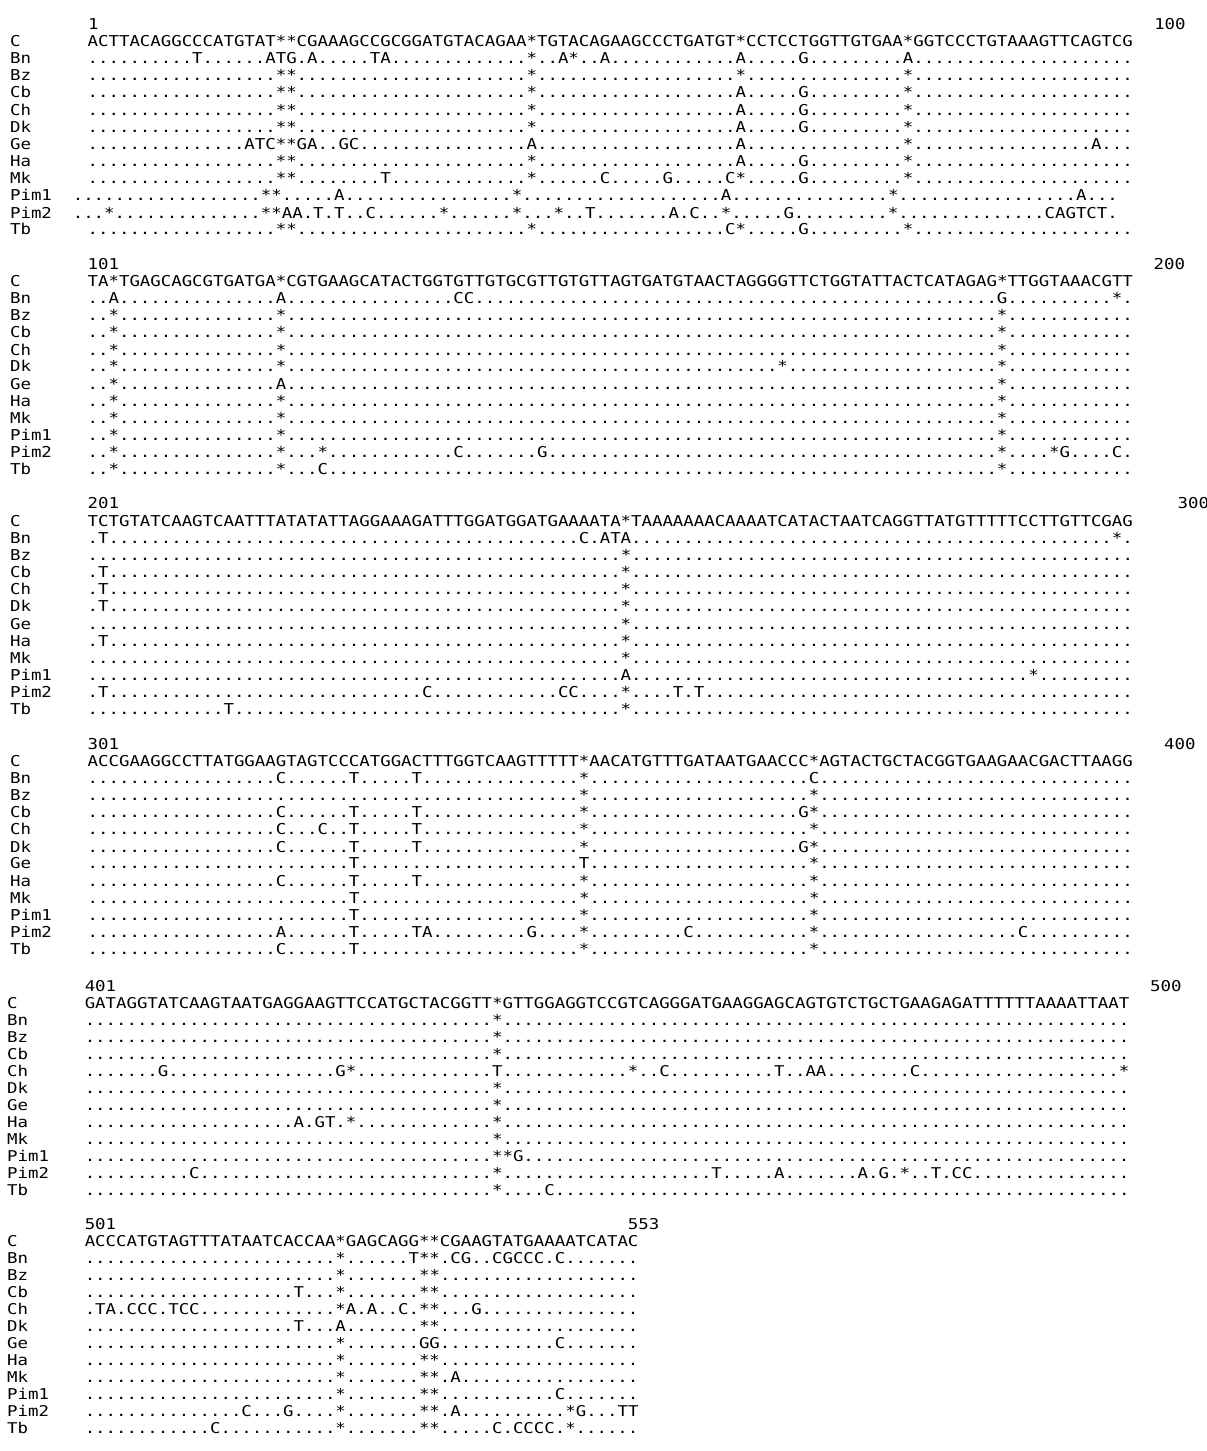
Fig. 3. Multiple alignment of CP nucleotide sequences of Tunisian TYLCV isolates. C indicates consensus sequence. Asterisks show deletions. Dots indicate nucleotides identical to the